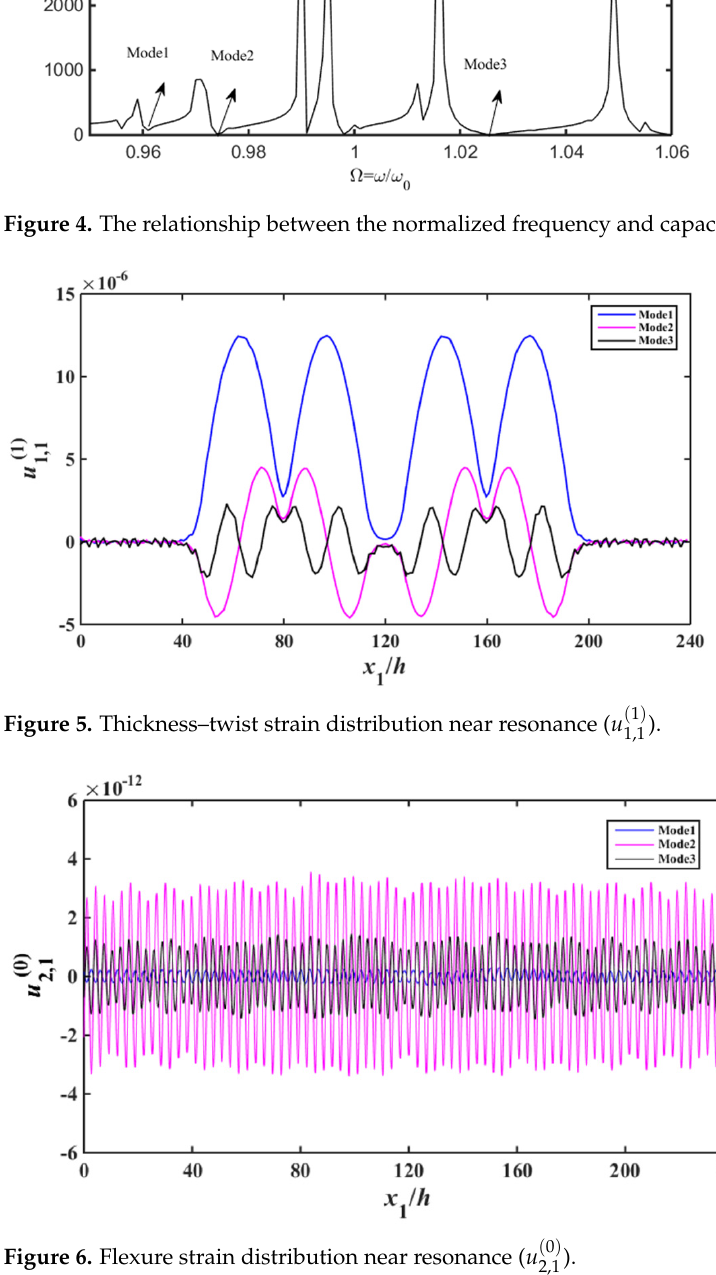
Figure 6. Flexure strain distribution near resonance ( u